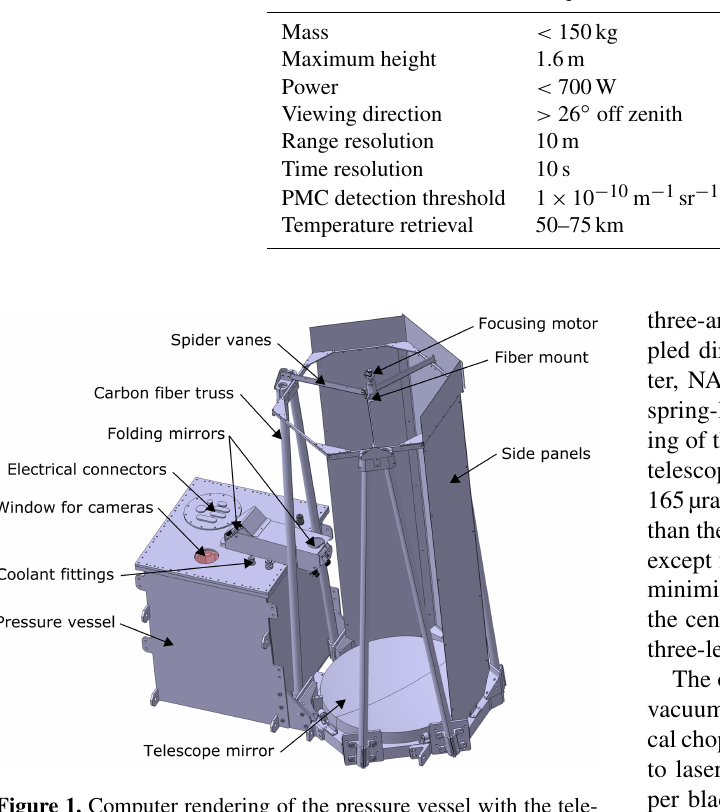
Figure 1. Computer rendering of the pressure vessel with the tele- scope attached (three side panels